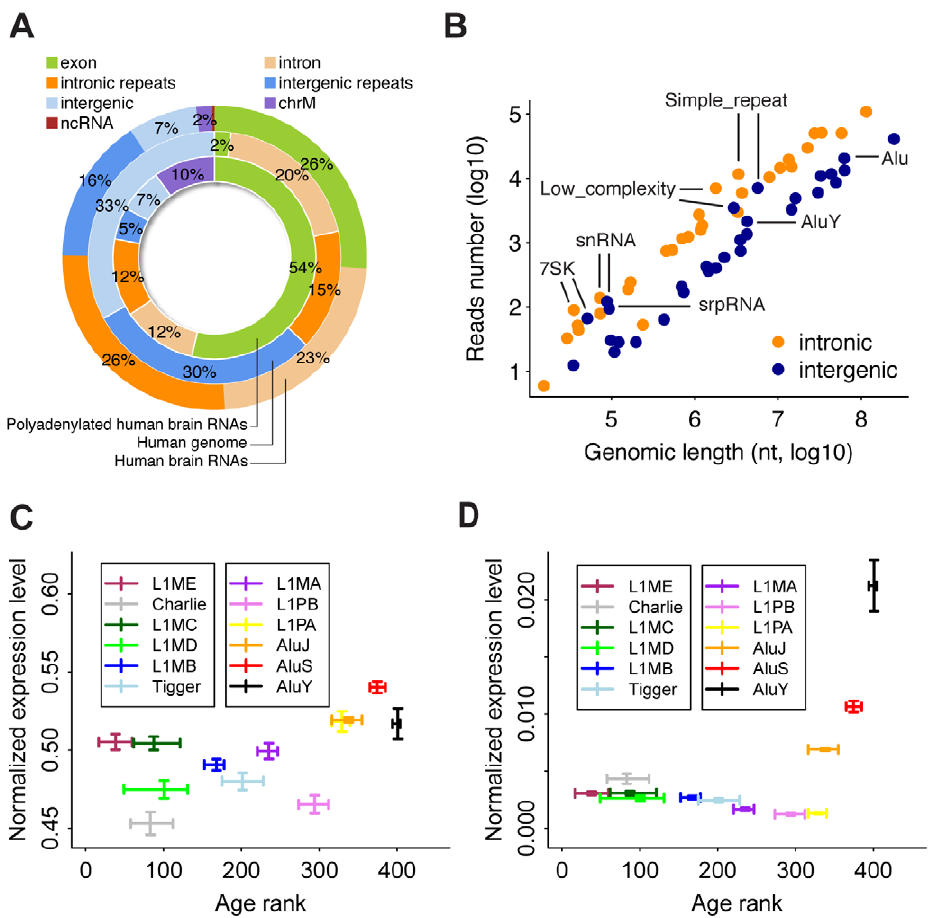
Figure 1. Composition of human brain transcriptome and transcription of repetitive elements. (A) Outer circle: average proportions of transcriptome sequence reads from the two human samples that map within annotated exons (green), introns (light orange), intronic repeats (orange), intergenic repeats (blue), intergenic regions (light blue), mitochondrial DNA (purple), and ncRNA (maroon). Middle circle: the proportions occupied by the corresponding regions in the human genome. Inner circle: the proportions of transcriptome sequence reads for polyadenylated human brain RNA (data adopted from [26]). (B) The transcriptional activity of repeat families located within introns (orange) or intergenic regions (blue) plotted against the total genomic length occupied by the family (see Materials and Methods for details). The labels indicate the repeat families with elevated expression levels. (C and D) The expression levels of twelve TE families normalized by the total genomic length of the corresponding family (C) and by the length corresponding to expressed repeats (D), plotted against their age rank. The expression level 95% confidence intervals are calculated by 1,000 bootstraps over sequence reads. The age rank and the corresponding confidence intervals are plotted according to [39]. Higher age rank corresponds to evolutionary younger TE